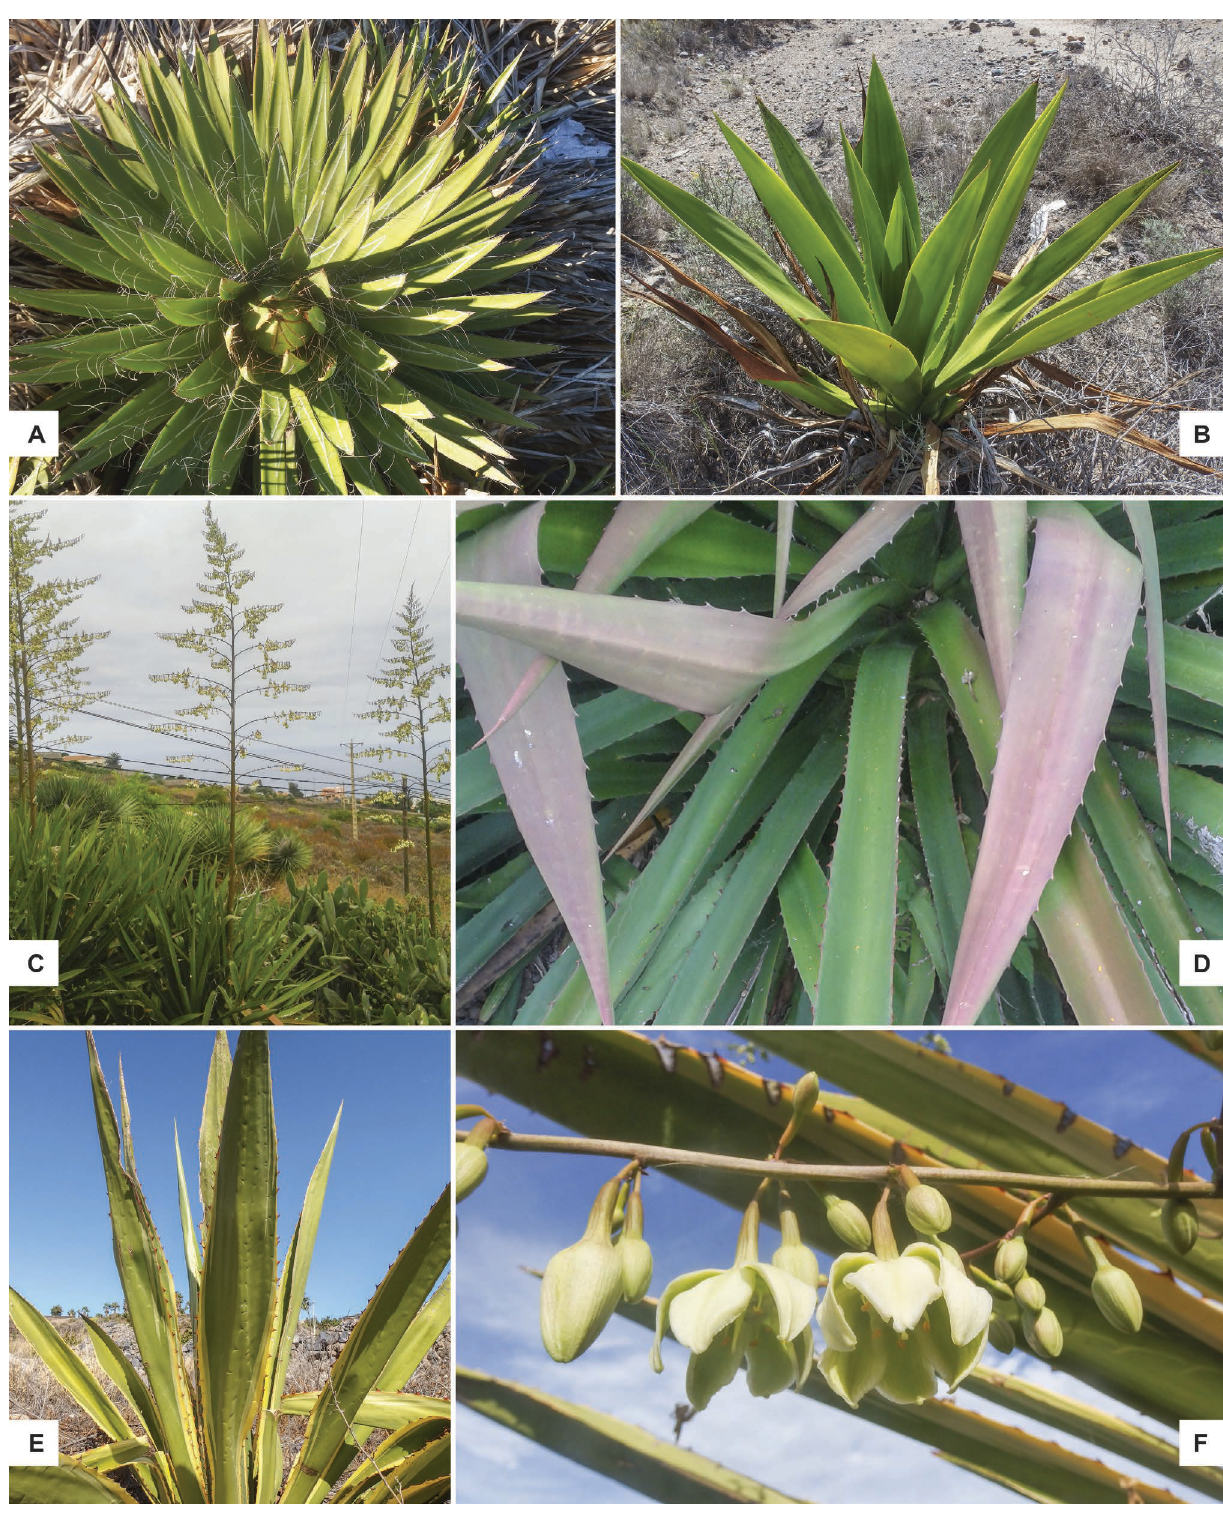
Figure 7 – A . Agave filifera , Güímar (T), December 2018. Leaf margins unroll as hair-like threads. B . Furcraea foetida , Adeje, Playa de las Americas (T), November 2016. Leaf margins are either smooth or prickly only in the lower half of the blade. C . F. hexapetala , San Cristóbal de La Laguna (Valle de Guerra) (T), August 2014. D . Idem. Detail of leaves. E . F. selloana , Adeje, Playa de las Américas (T), March 2016. Nearly all plants seen in the study area belong to a variegated form, var. marginata . Leaf margins are spiny throughout and the red spines contrast a lot with the pale greenish blade. F . Idem, Fasnia (T), December 2018. In Furcraea , contrary to Agave , flowers are pendent and tepals whitish. Photographs: A, B, E, F by F. Verloove; C, D by A.